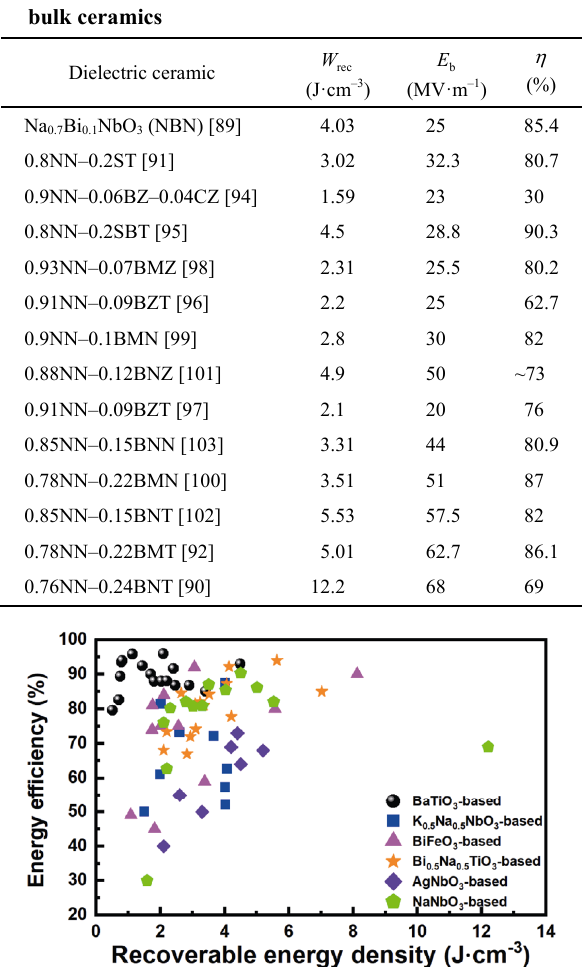
Fig. 15 Comparison of the energy-storage properties at room temperature between various lead-free non-linear dielectric ceramics [25,27,28,31–33,35–39,40–46,48–55,